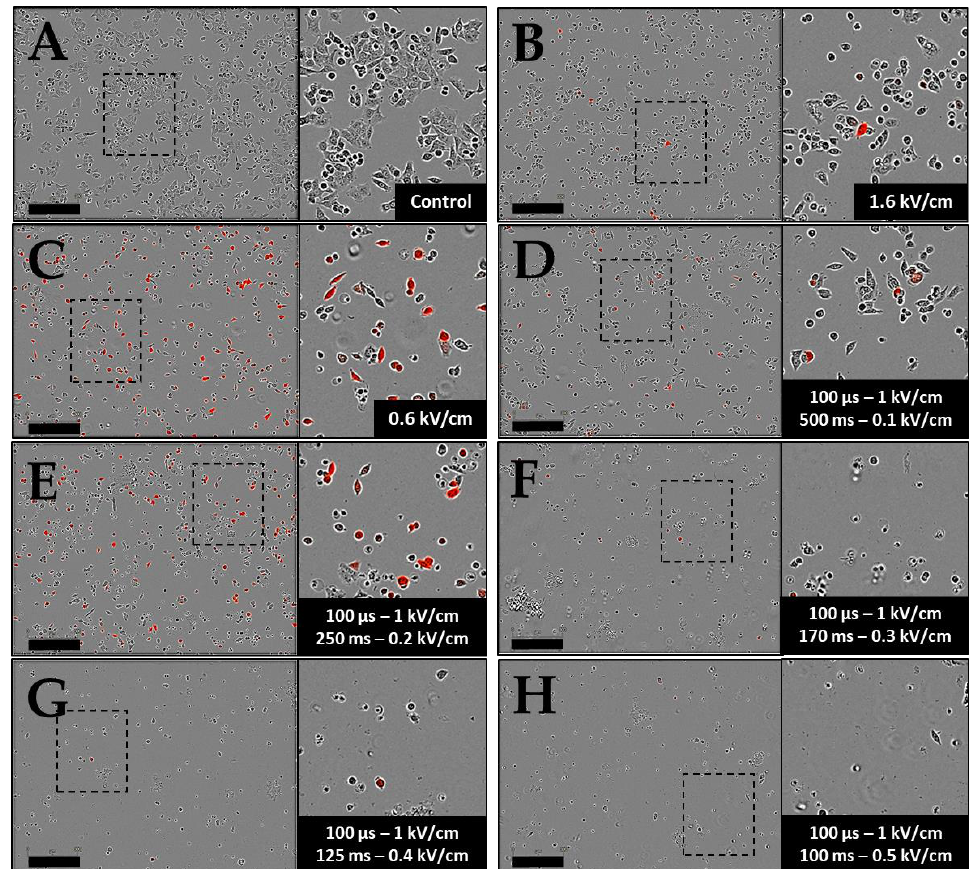
Figure 5. Representative HCT-116 cells electrotransfection micrographs. Cells were observed 24 h after pulsation by bright field/fluorescence wide-field microscopy. Cells were incubated with 40 µg/mL plasmid encoding tdTomato, and ECT pulse parameters (8 pulses of 100 µs at 1 Hz with variables field intensity (1.4 to 2 kV/cm)), GET pulse parameters (10 pulses of 5 ms at 1 Hz with variables field intensity (0.5 to 0.9 kV/cm)) and HV-LV parameters with HV constant (100 µs of 1 kV/cm) and variable LV (500 ms of 0.1 kV/cm ; 250 ms of 0.2 kV/cm ; 170 ms of 0.3 kV/cm ; 125 ms of 0.4 kV/cm and 100 ms of 0.5 kV/cm) were applied. ( A ) Control, ( B ) ECT pulse parameters, ( C ) GET pulse parameters, ( D – H ) HV-LV pulse parameters. Cells expressing tdTomato emitted red fluorescence 24 h after pulsation. Scale bar = 300 µm. Zoom on the right corresponds to the rectangle in the entire image.